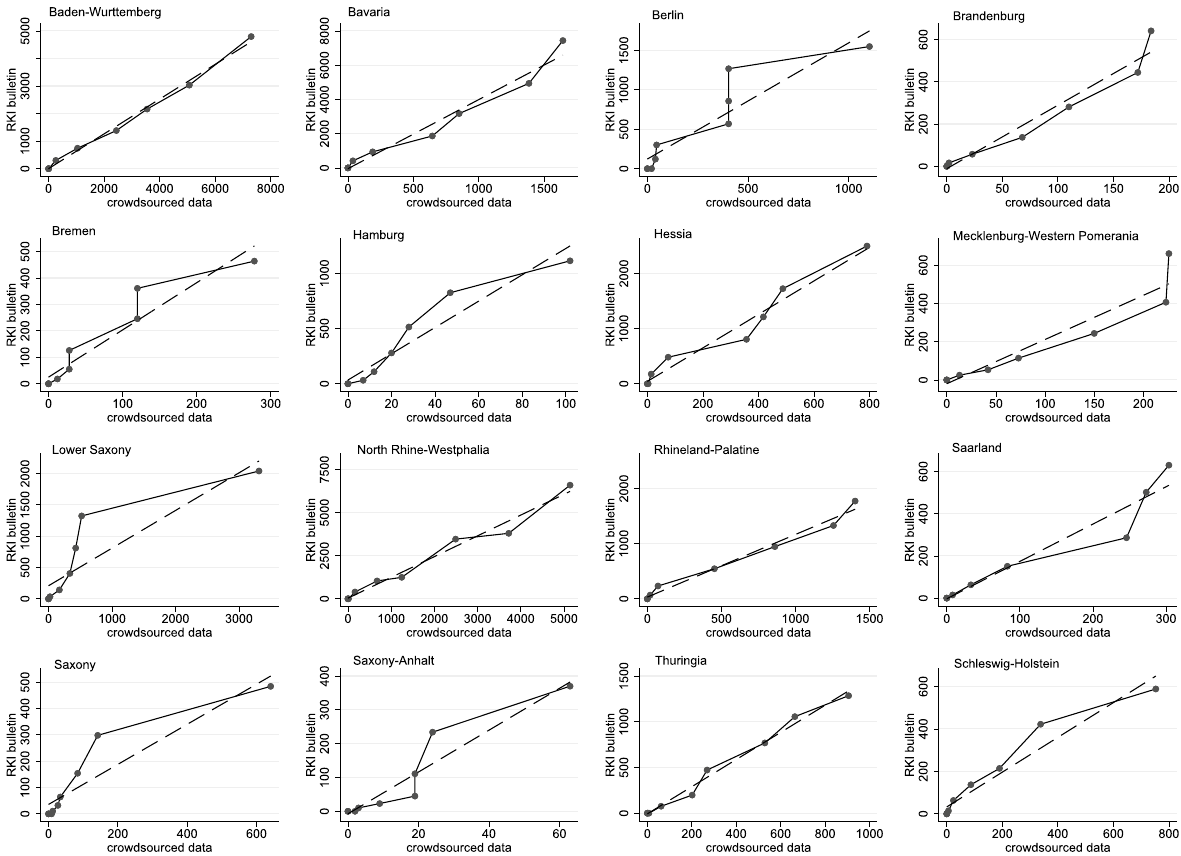
Figure 5. Regional variation of VOC coverage in crowdsourced data. The individual panels correlate the cumulative development of VOC cases covered in the close to real-time virus variant-tracking crowdsourcing project by 15 to those reported by German health authorities later on and documented in 14,24,25 at the German federal state (NUTS-1) level. Dashed lines in each panel indicate the linear fit between crowdsourced and RKI